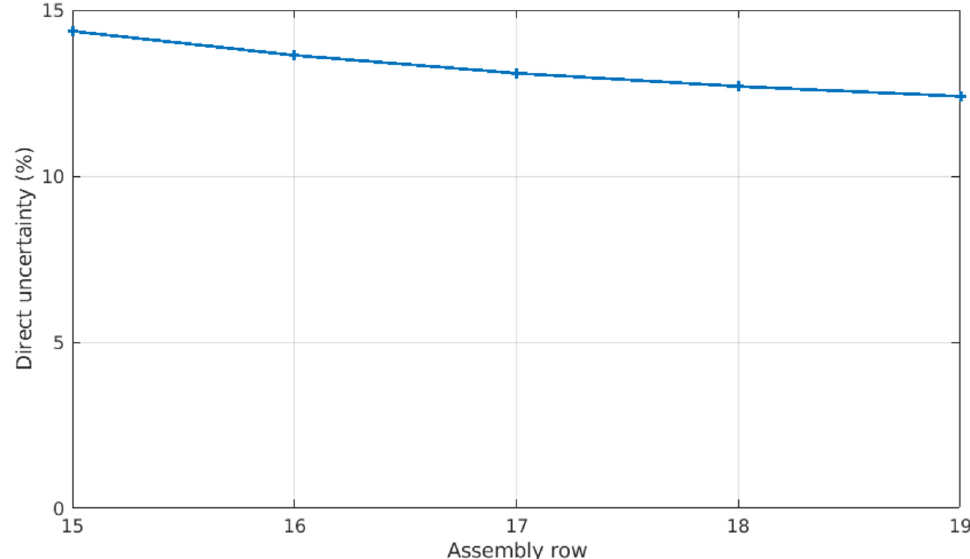
Fig. 33. Direct uncertainty due to nuclear data for production of tritium particles in neutron